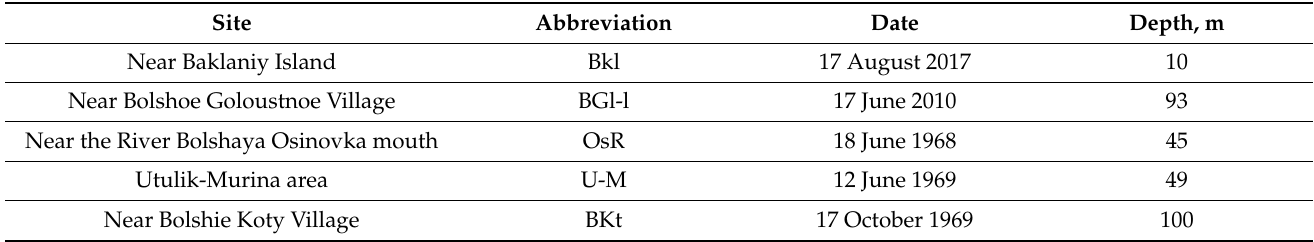
Table 2. Information regarding samples from Lake Baikal used for comparisons of species